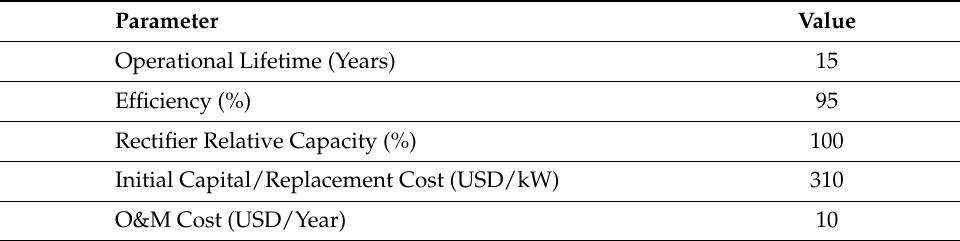
Table 8. Converter Specifications.